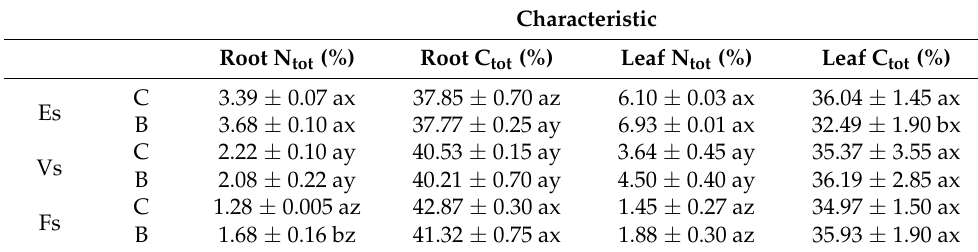
Table 3. Measurements of total nitrogen (N tot ) and total carbon (C tot ) were performed on roots and leaves of untreated (C) and biochar-treated (B) Solanum lycopersicum var. cerasiforme plants at the early stage (Es, 36 days after plant germination), vegetative stage (Vs, 84 days after plant germination), and fruit stage (Fs, 140 days after plant germination). Letters a and b indicate a statistically significant difference ( p < 0.05) between the two treatments inside each sampling point. Letters x, y, and z indicate a statistically significant difference ( p < 0.05) among the Es, Vs, and Fs sampling points for each treatment. ( n = 6 ± SE). Characteristic Root N tot (%) Root C tot (%) Leaf N tot (%) Leaf C tot